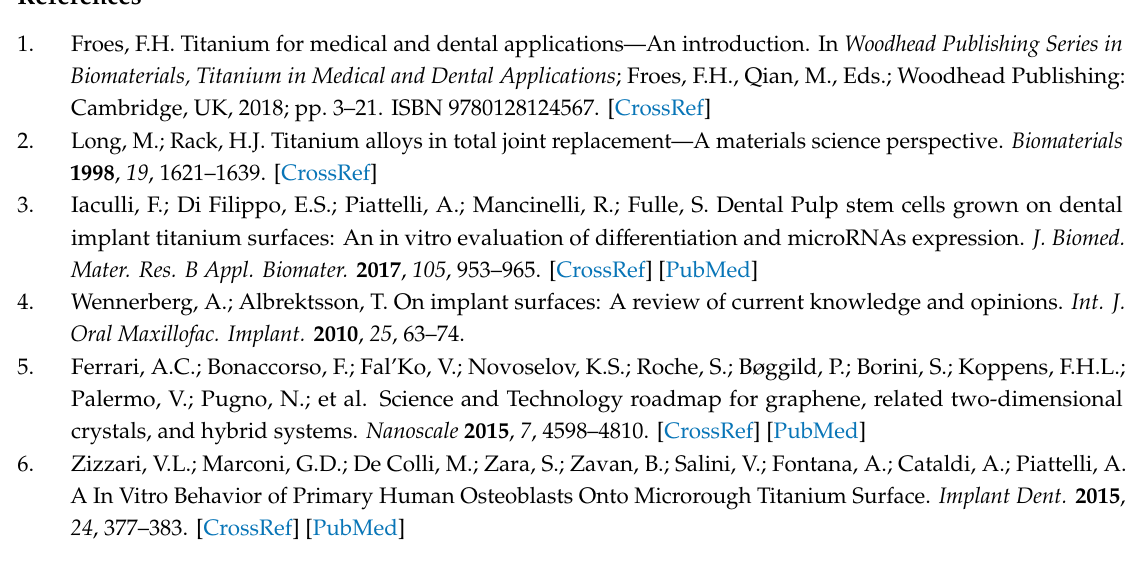
Table S1: R a , R q , R max , S dq, and S dr values obtained from five individual measurements, using Multimode 8 Bruker AFM and nanoscope analysis